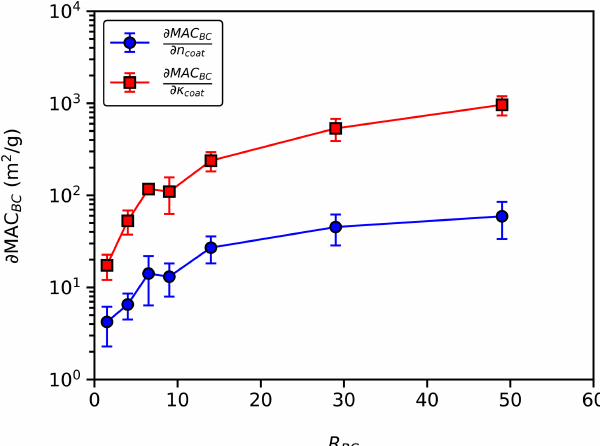
Figure 3. Average change in MAC BC per change in coating real refractive index ( ∂ MAC BC /∂n coat ) and average change in MAC BC per change in coating imaginary refractive index ( ∂ MAC BC /∂κ coat ) with constant φ . We find that ∂ MAC BC /∂κ coat is 4 to 16 times greater than ∂ MAC BC /∂n coat , depending on R BC . These results imply that the choice of the coating imaginary refractive index is more important than the choice of the coating real refractive index when calculating MAC BC . Error bars represent 1 standard devia-